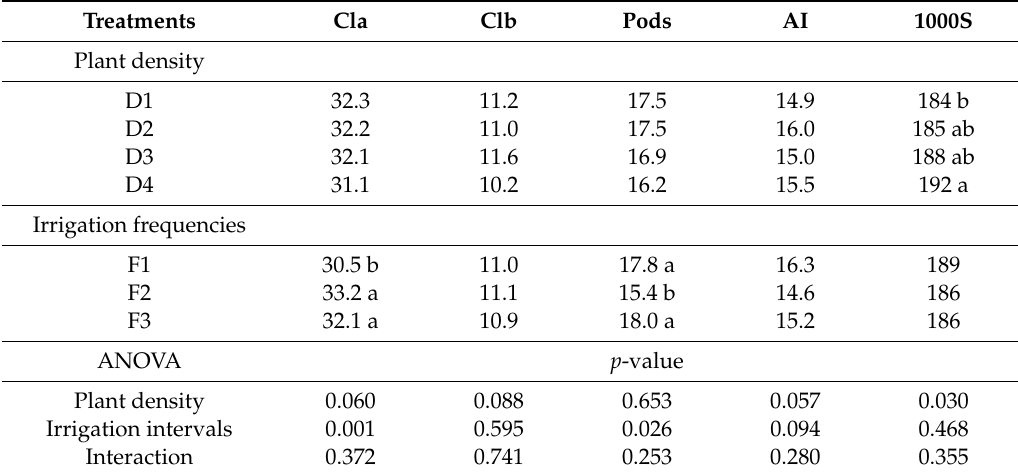
Planting density